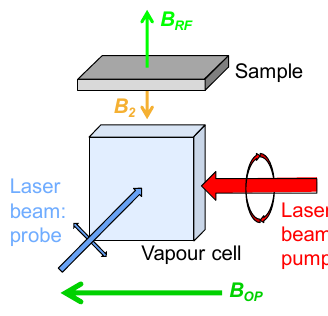
Figure 3. Configuration of a radio-frequency atomic